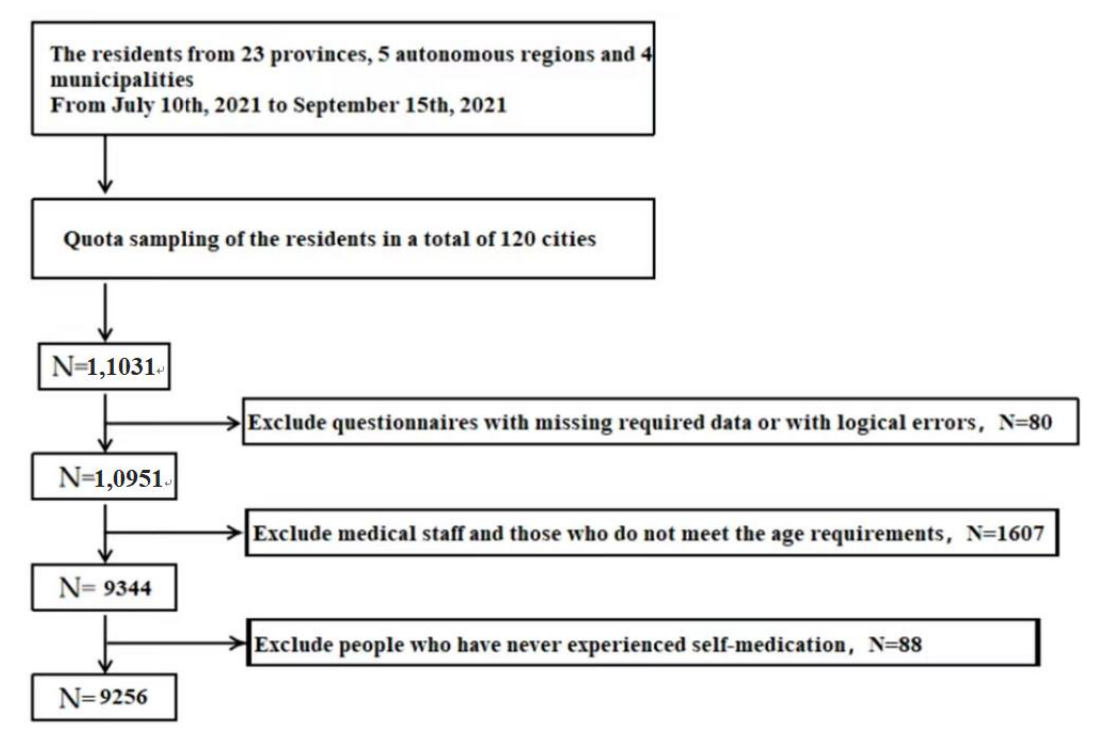
Figure 1. Flowchart of participant enrollment.